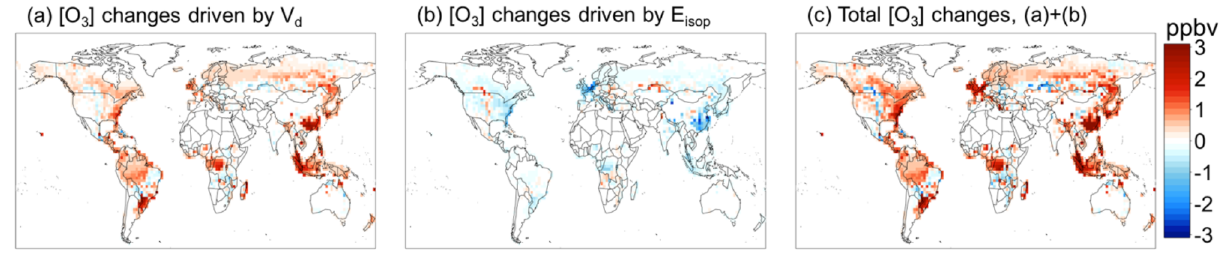
Figure 7. Attribution of simulated ozone changes to (a) changes in dry deposition only; (b) changes in biogenic isoprene emission only; and (c) changes in both dry deposition and isoprene emission combined, based on the statistical model developed by Wong et al.